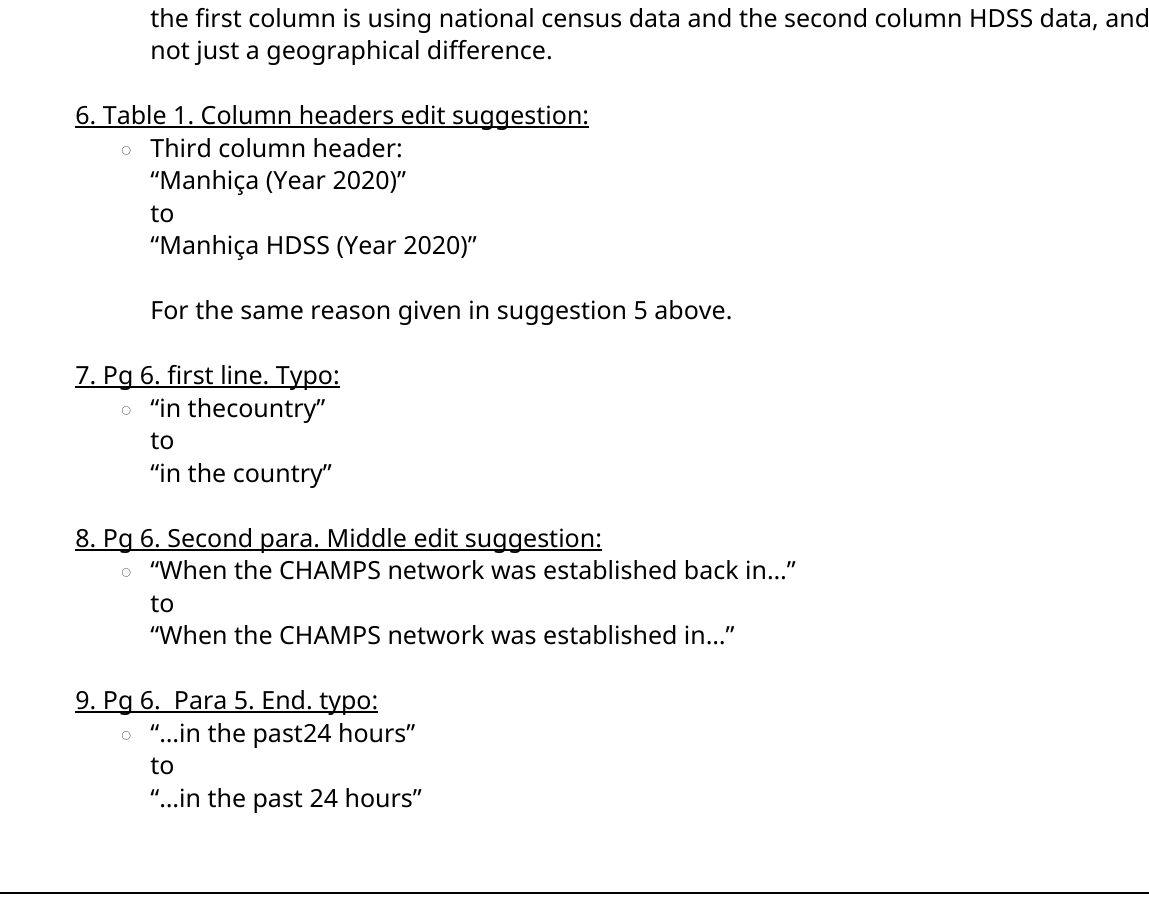
6. Table 1. Column headers edit